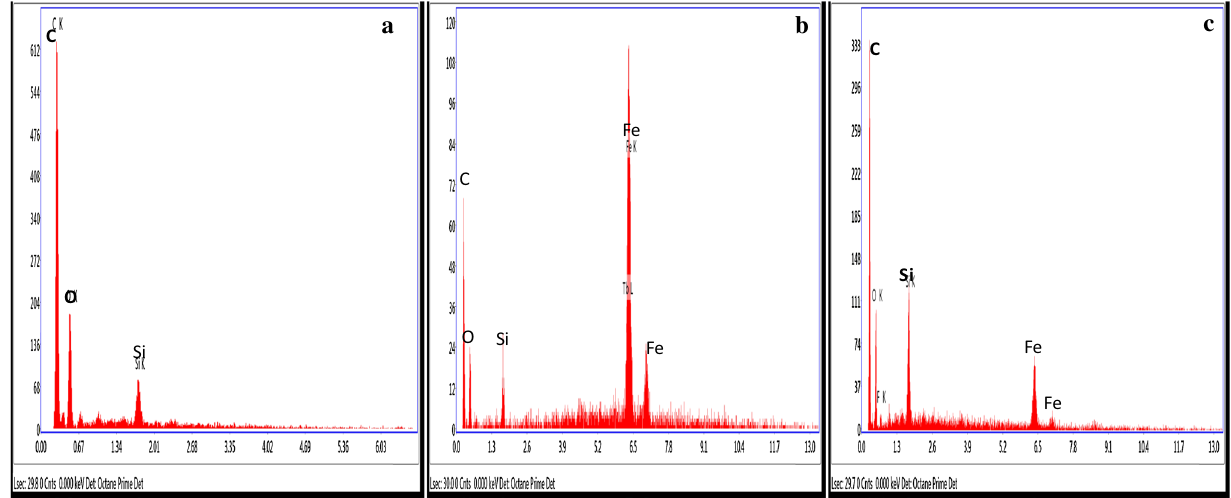
Fig. 3 EDX analysis of a SH, b MSH and c MSH after adsorption